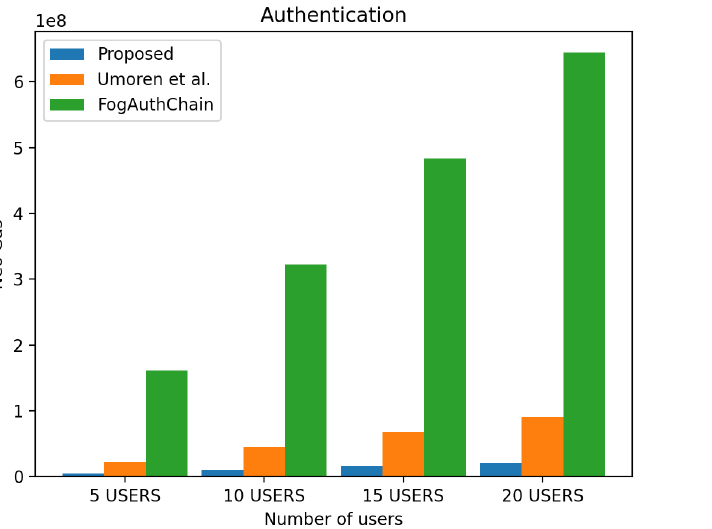
Figure 8. Evaluation ofexperimental results on authentication gas for the proposed system and the existing system